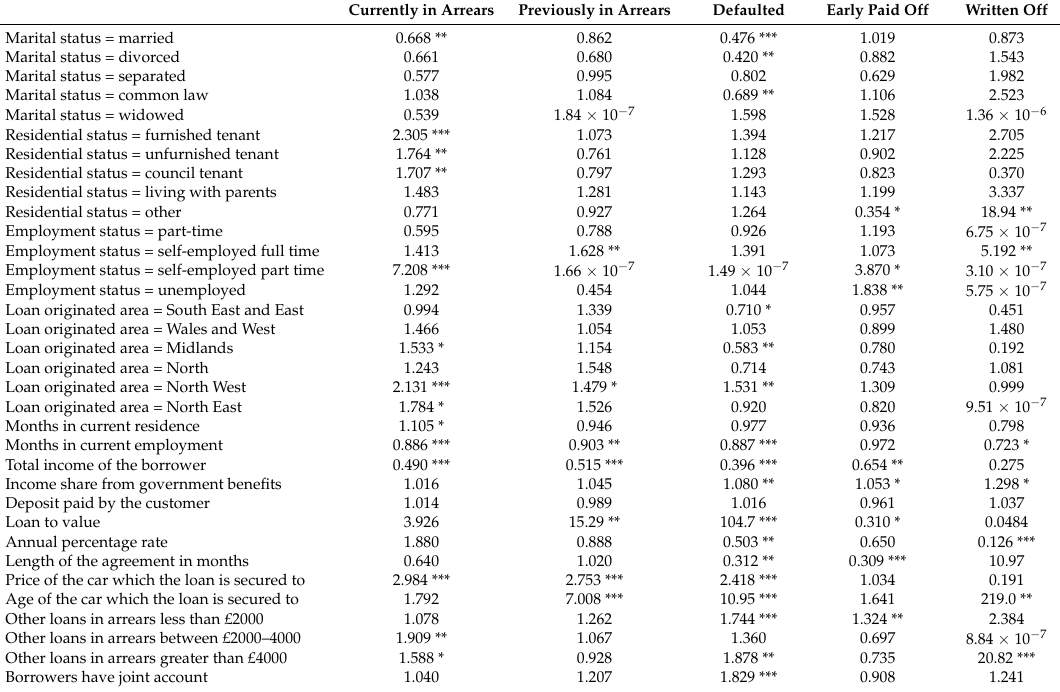
Table 6. Analysis of arrears, defaults, early repay, and written-offs (relative risk ratios). Currently in Arrears Previously in Arrears Defaulted Early Paid Off Written